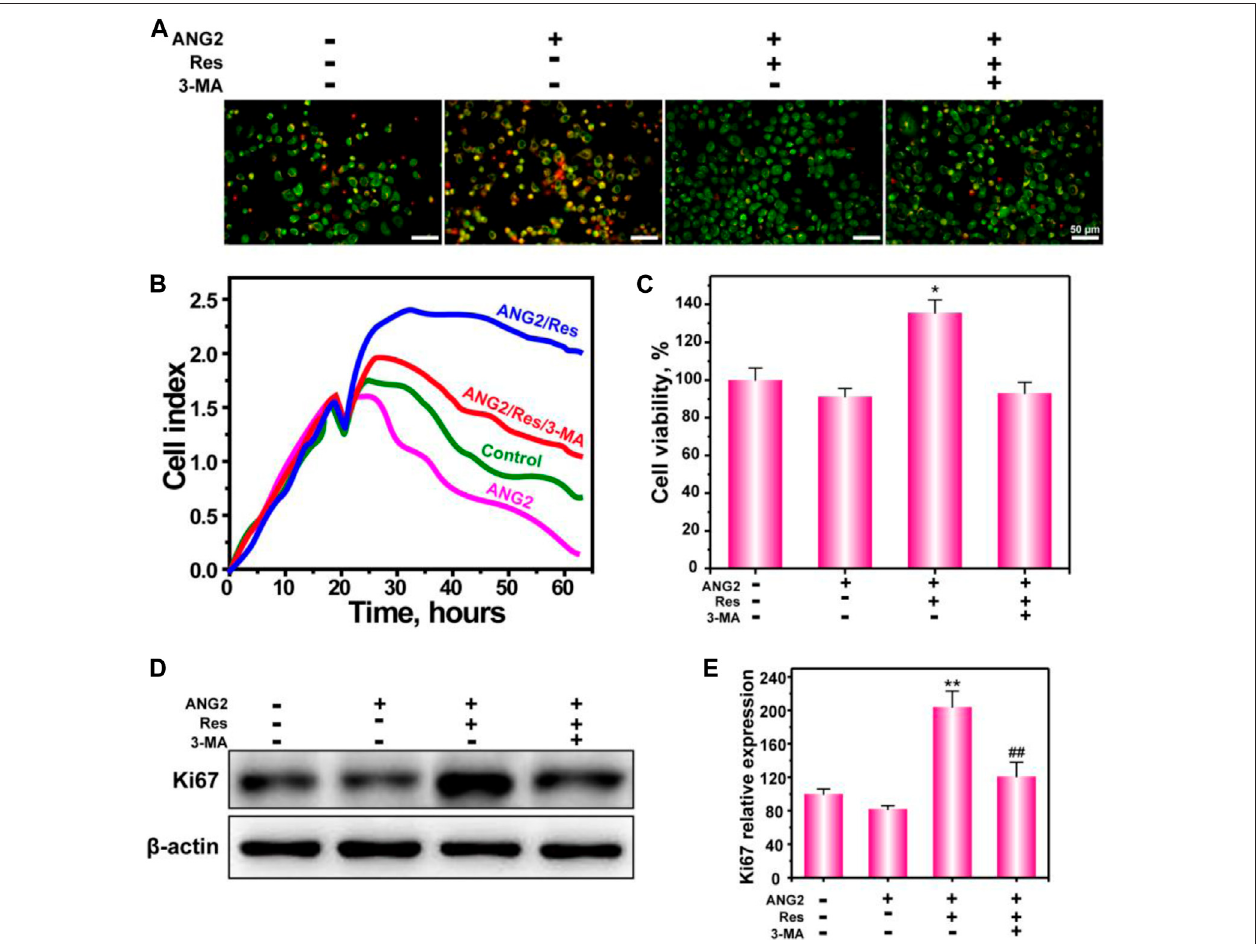
FIGURE5| SurvivalofHUVECstreatedwithANG2,Res,and3-MAinanoxygen-de fi cientenvironment.AO-EBstainingat24 h (A) ,real-timecellgrowthcurve (B) , cell viability by MTT assay at 24 h (C) , and protein expression of Ki67 (D) . The values are represented as the mean ± SD ( n (cid:1) 3). * p < 0.05, ** p < 0.01 vs ANG2 group; # p < 0.05, ## p < 0.01 vs ANG2/Res